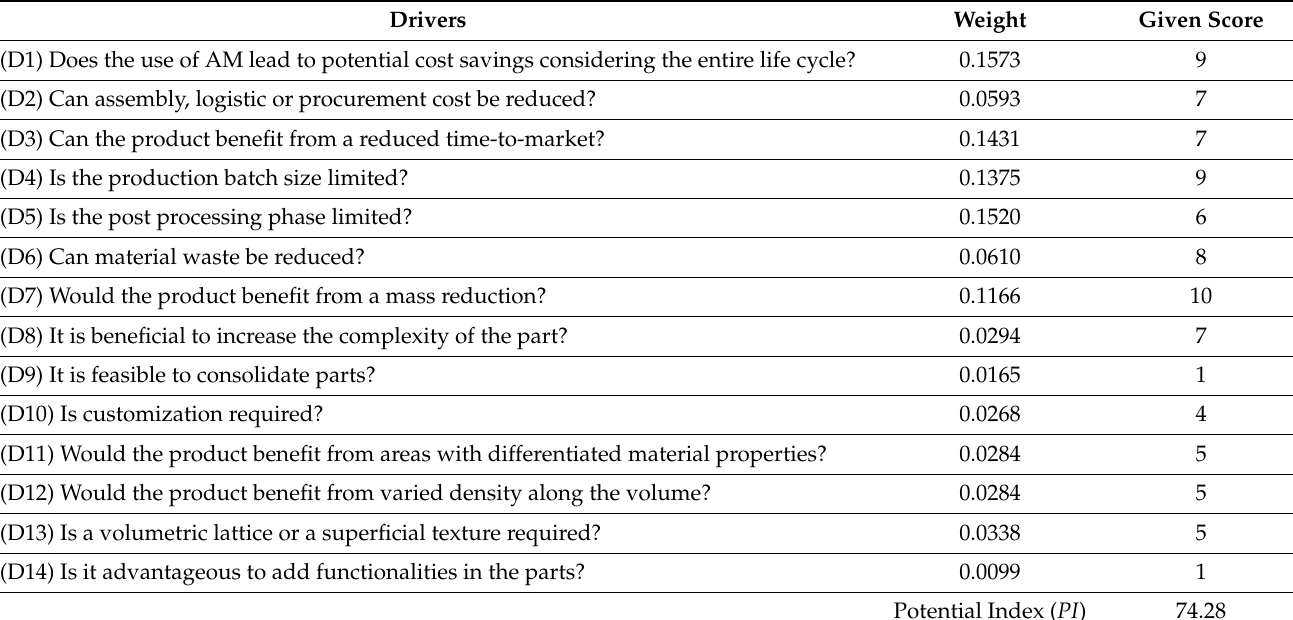
Table 14. Potential index calculation for the PPC